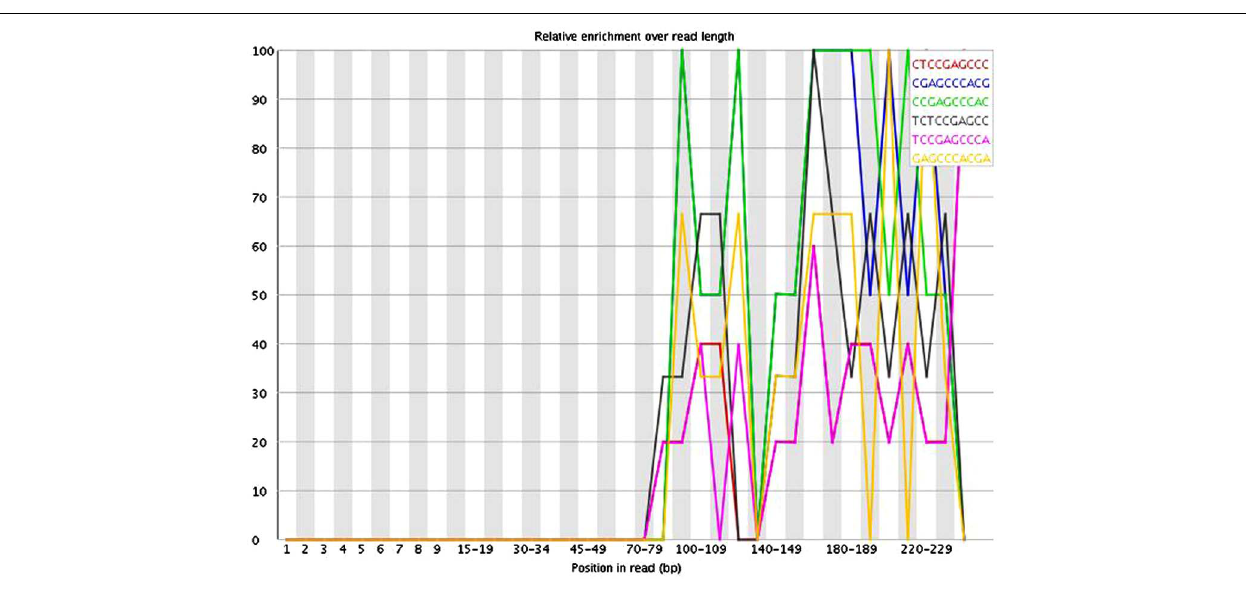
IDENTIFICATION OF ADAPTER